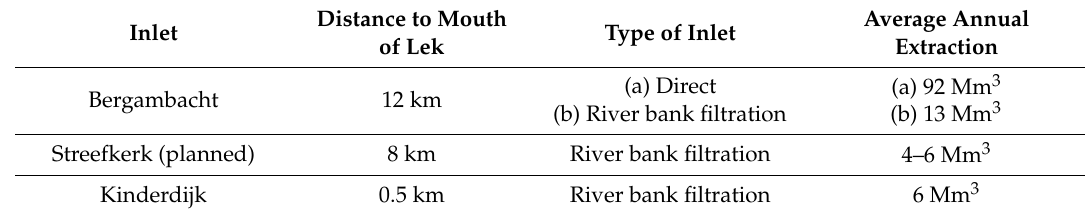
Figure 2. Location of the drinking water inlets along the Lek river. Figure 2 Location of the drinking water inlets along the Lek river. Table 1. Location and annual extraction volumes of drinking water inlets along the Lek Table 1 Location and annual extraction volumes of drinking water inlets along the Lek river.